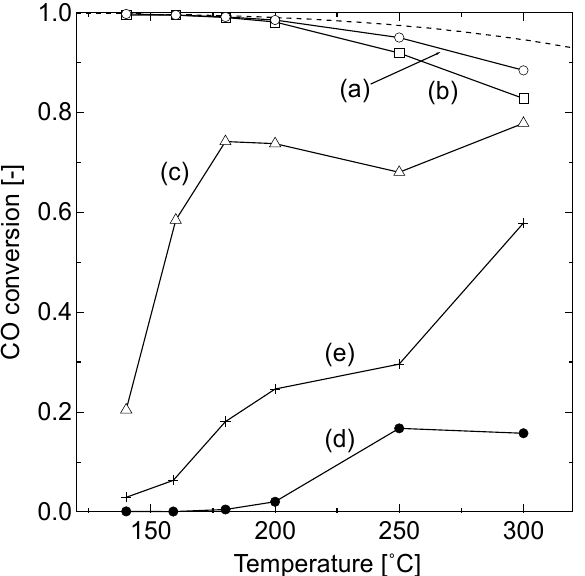
Figure 1. Catalytic performance of Au/Fe H /CO/CO /H O = 45.9/8.3/4.1/41.7%, and GHSV = 2600 h − 1 ); samples calcined at 2 2 2 200 °C with Au contents of ( a ) 10 wt%; ( b ) 3 wt%; ( c ) 1 wt%; ( d ) with no Au and ( e ) calcined at 400 °C with Au content of 3 wt%, and equilibrium CO conversion (dashed